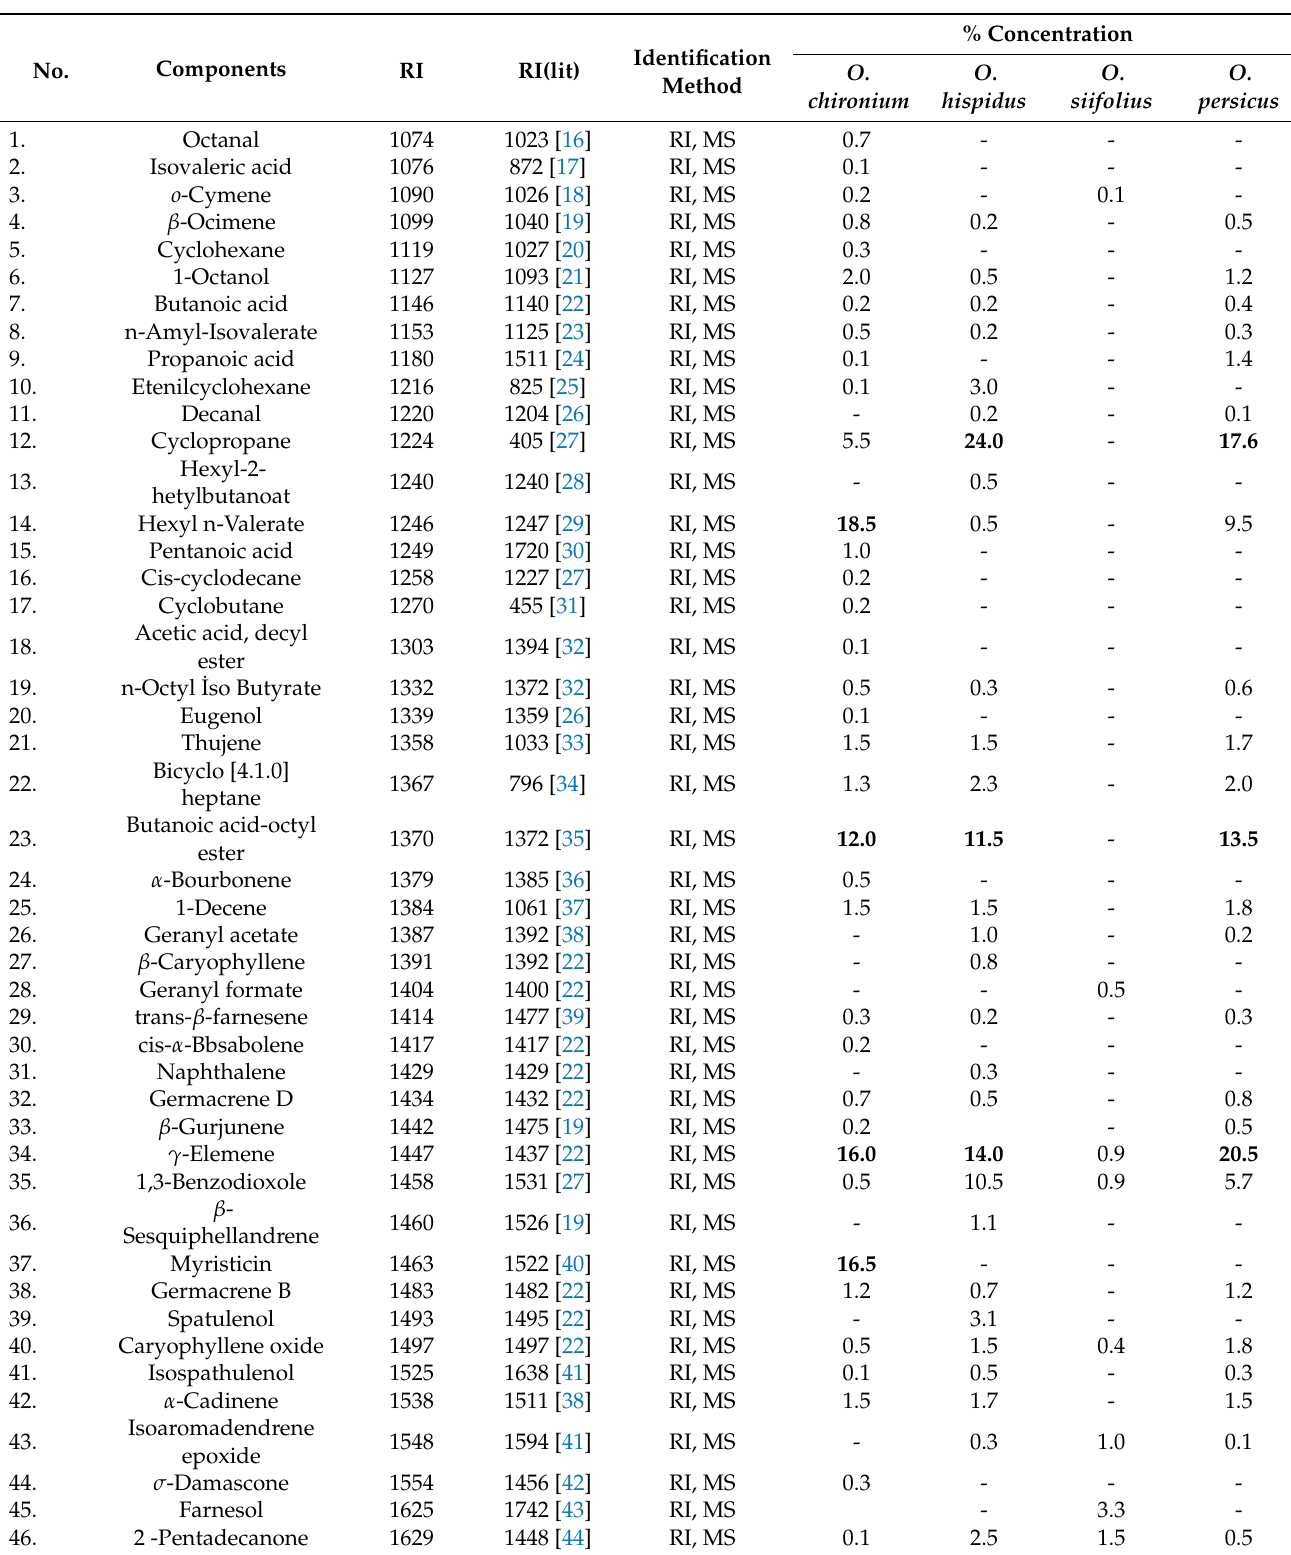
Table 1. Components of the essential oils from species of the Opopanax